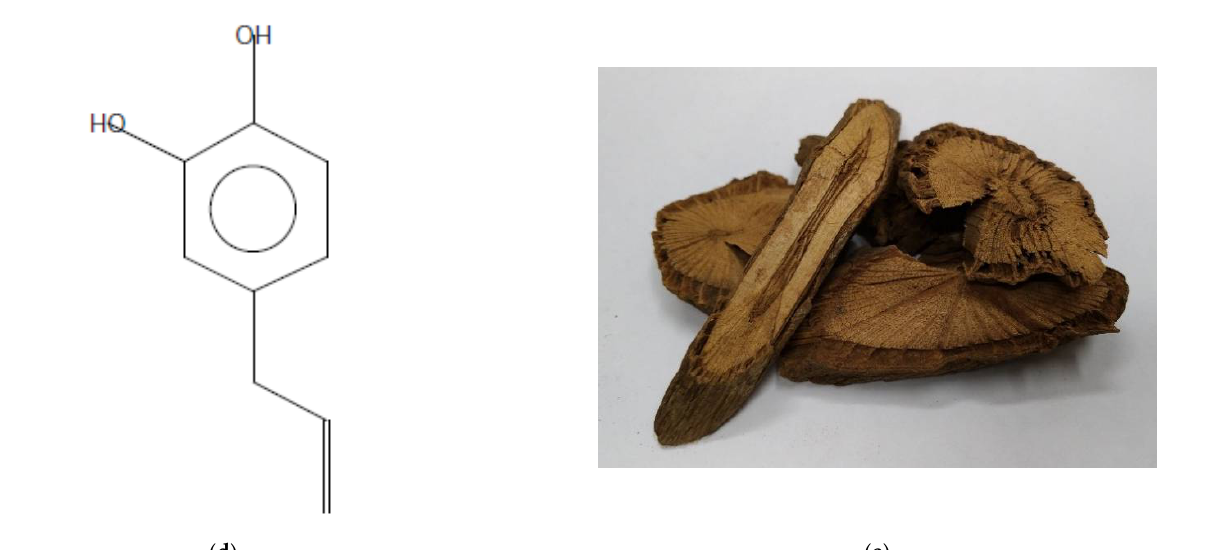
Figure 8. The peak signals of PKE from GCMS analysis ( a ), the structure of bicyclo[2.2.1]heptan-2-ol, 1,7,7-trimethyl-, (1S-endo)- ( b ), alpha-humulene ( c ), hydroxychavicol ( d ), and dry Piper kadsura ( e ).